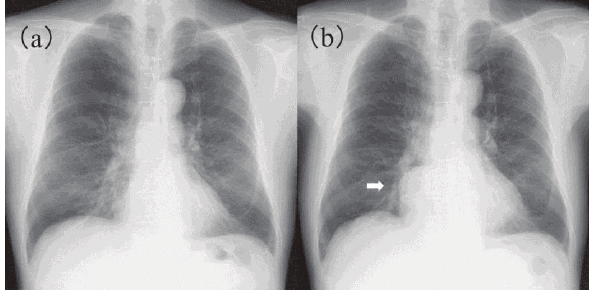
Figure 1: Chest radiography findings.